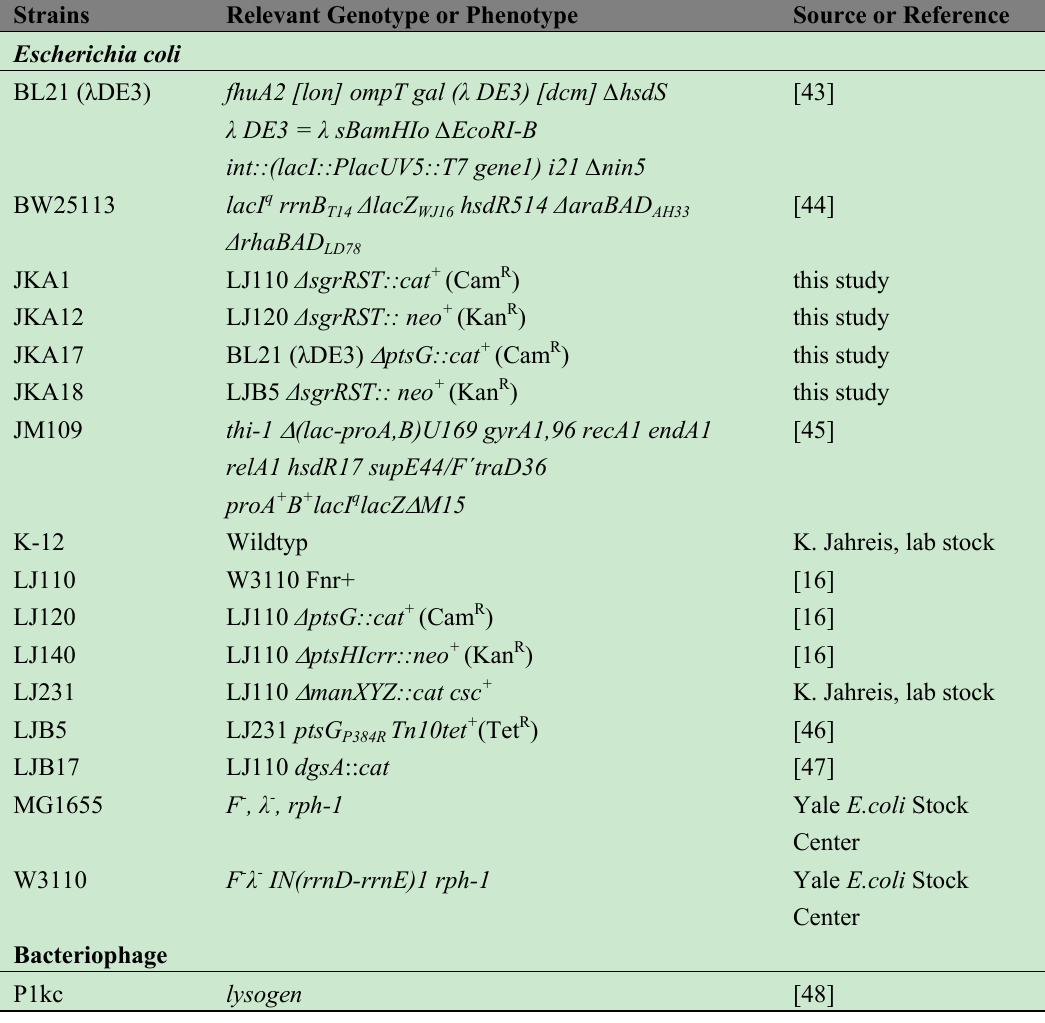
Table 1. Strains and Phages used in this study.